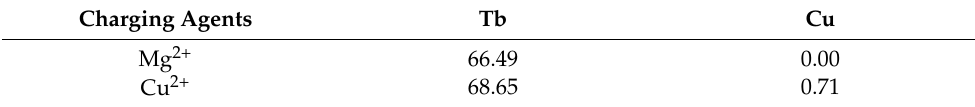
Table 1. ICP element analysis results of coating.